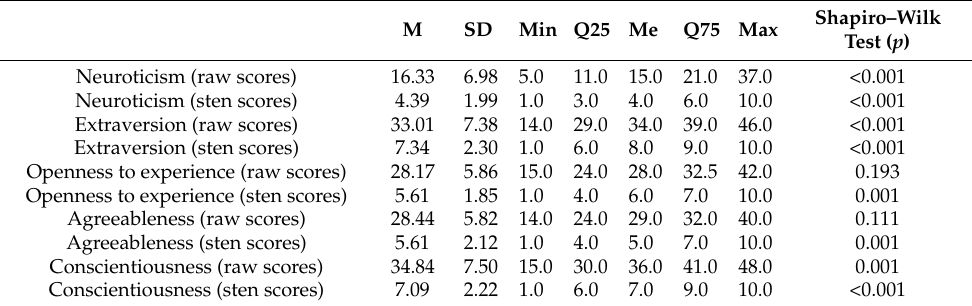
Table 1. Values of descriptive statistics for the personality profile of American football players aged 20–29 years in